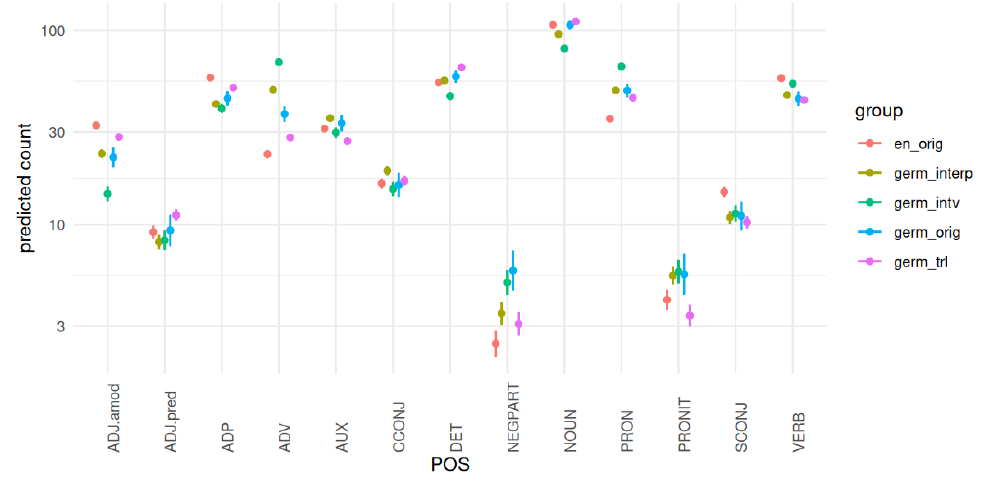
Figure 6. Predicted frequencies (log-transformed) for text of average length, with 95% confidence intervals, according to a Poisson